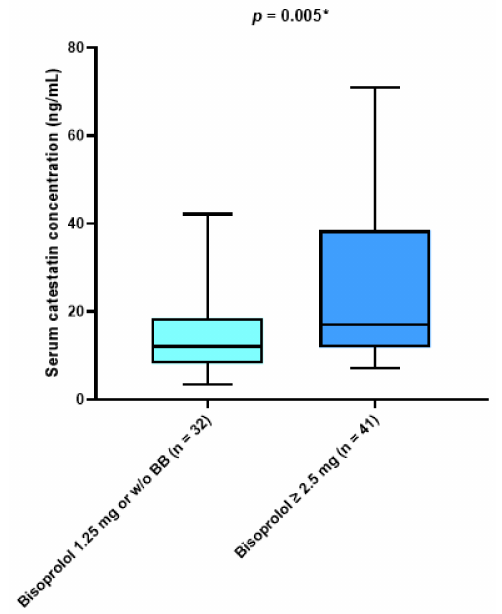
Figure 4. Comparison of serum catestatin concentrations with respect to beta-blocker therapy. Data are presented as median and interquartile range. * Mann–Whitney U